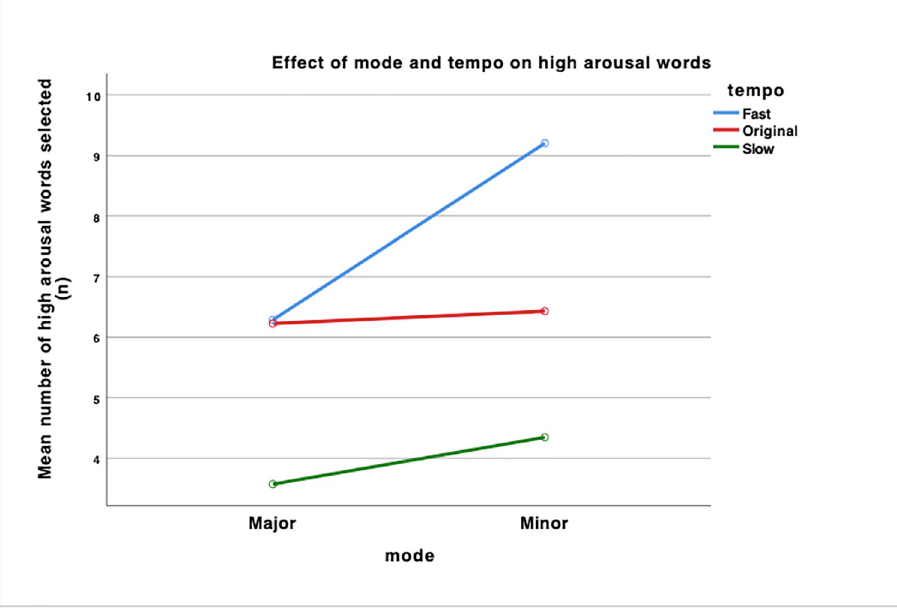
Fig 11. Interaction effect between the fast tempo and original tempo conditions on the mean number of high arousal words selected.